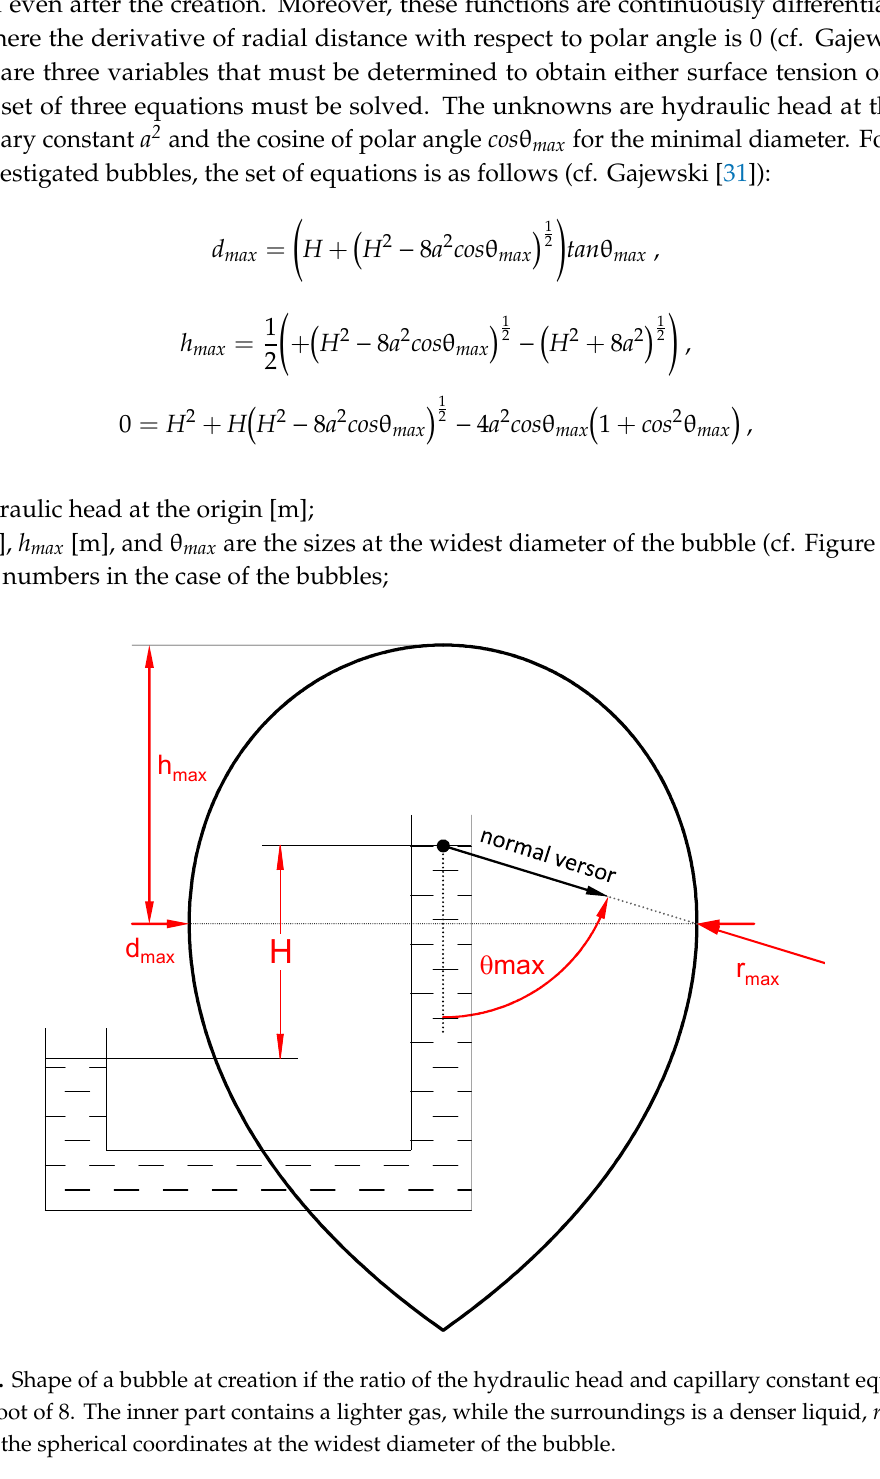
tension values as the reference.